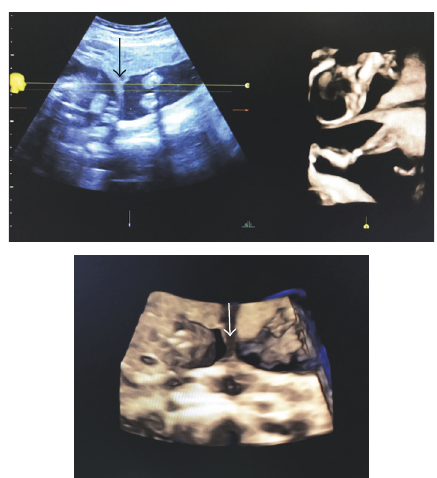
Figure 1: Thick septum separating the uterine cavities showing in 2D and 3D ultrasound mode. The arrows showed thick septum separating the uterine cavities showing in 2D and 3d ultrasound